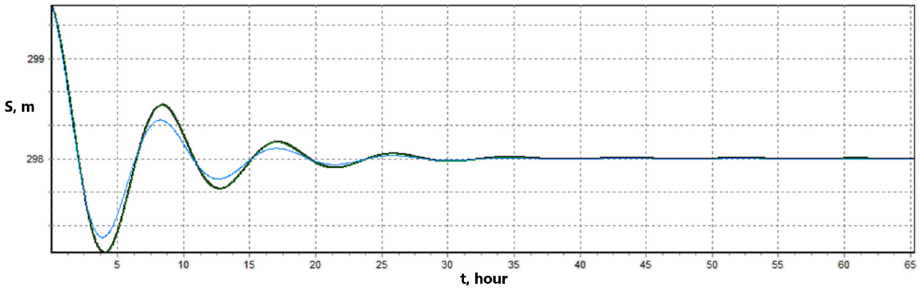
Figure 6. Result of the control system functioning at the set values.